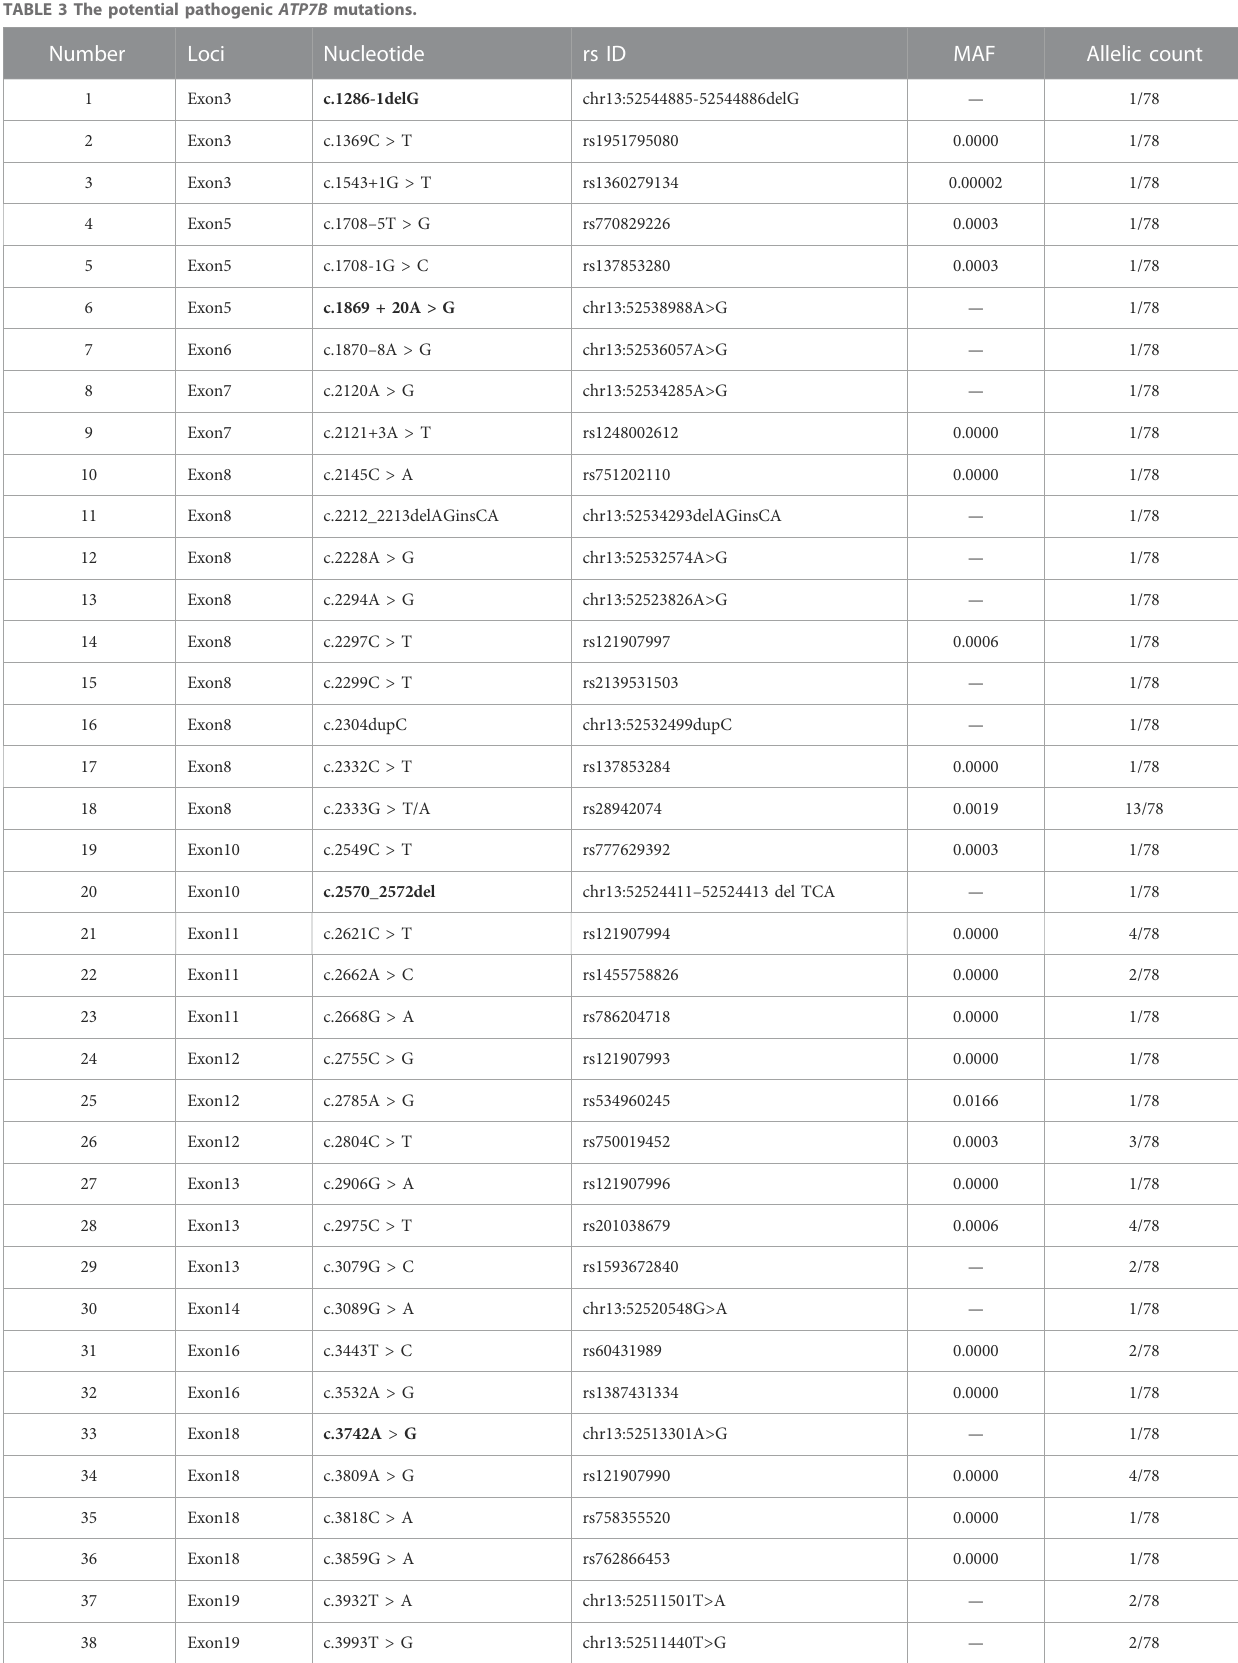
TABLE 3 The potential pathogenic ATP7B